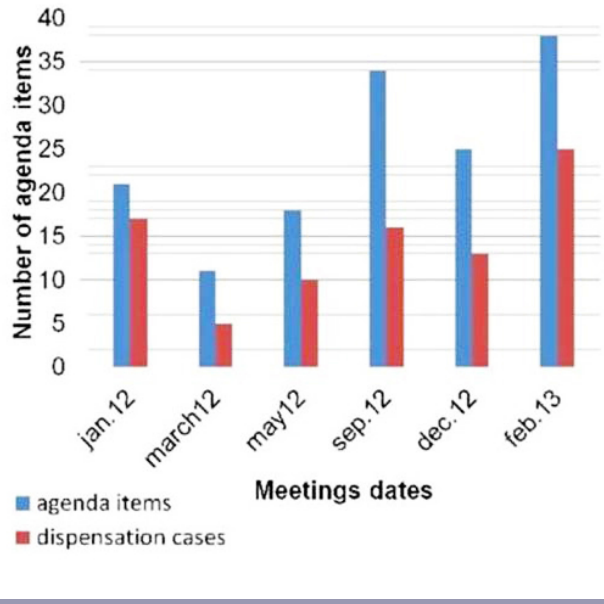
Fig. 3 . Agenda items at National Park Board